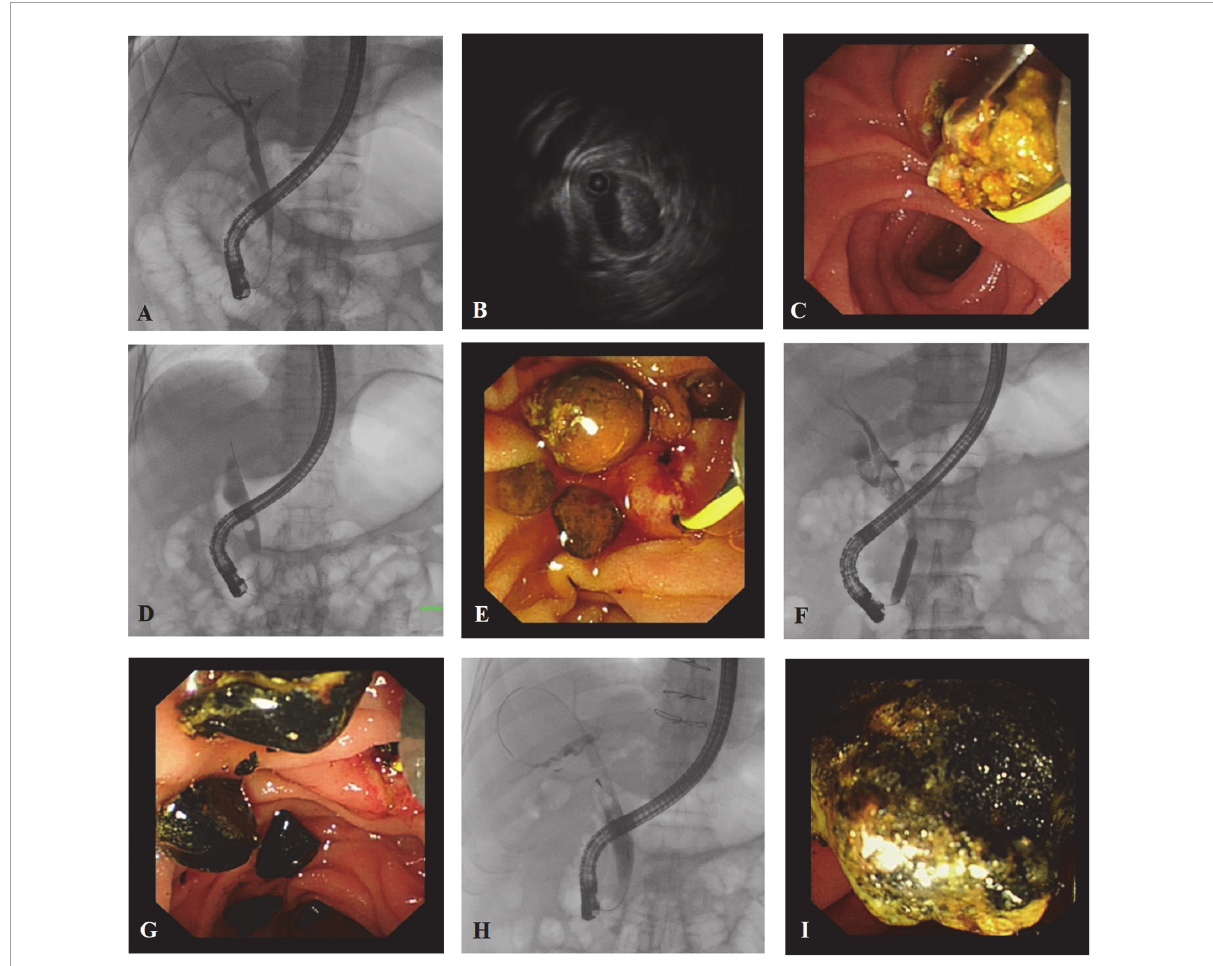
FIGURE2 Cholangiographic, IDUS, and endoscopic images from typical cases. Patient 1: A 37-year-old male choledocholithiasis patient was diagnosed with abdominal ultrasonography. (A) The cholangiographic image failed to reveal the stones. (B) IDUS confirmed the presence of stones in the bile duct, but the number of stones was not accurate. (C) During lithotomy, a large amount of sludge was pulled out. Since more than three extractions were done, the score of stones was modified as score 3. Patient 2: A 65-year-old female patient diagnosed with choledocholithiasis by abdominal CT scan. (D) Only one stone was found under the shaft of the endoscope, while stones inside the end of the common bile duct could not be seen. (E) More than five brownstones were extracted, and most of them existed in the lower part of the common bile duct. Patient 3: A 75-year-old male choledocholithiasis patient was diagnosed with abdominal ultrasonography. (F) Cholangiography demonstrated many stones in the middle part of the common bile duct, and stones in the cystic duct can also be seen. (G) Black calculus with different sizes was taken out. Patient 4: A 68-year-old male patient was diagnosed with choledocholithiasis by abdominal CT scan. (H) Stones < 1 cm were shown above the shaft by cholangiography. (I) The long diameter of the stone was around 1.2